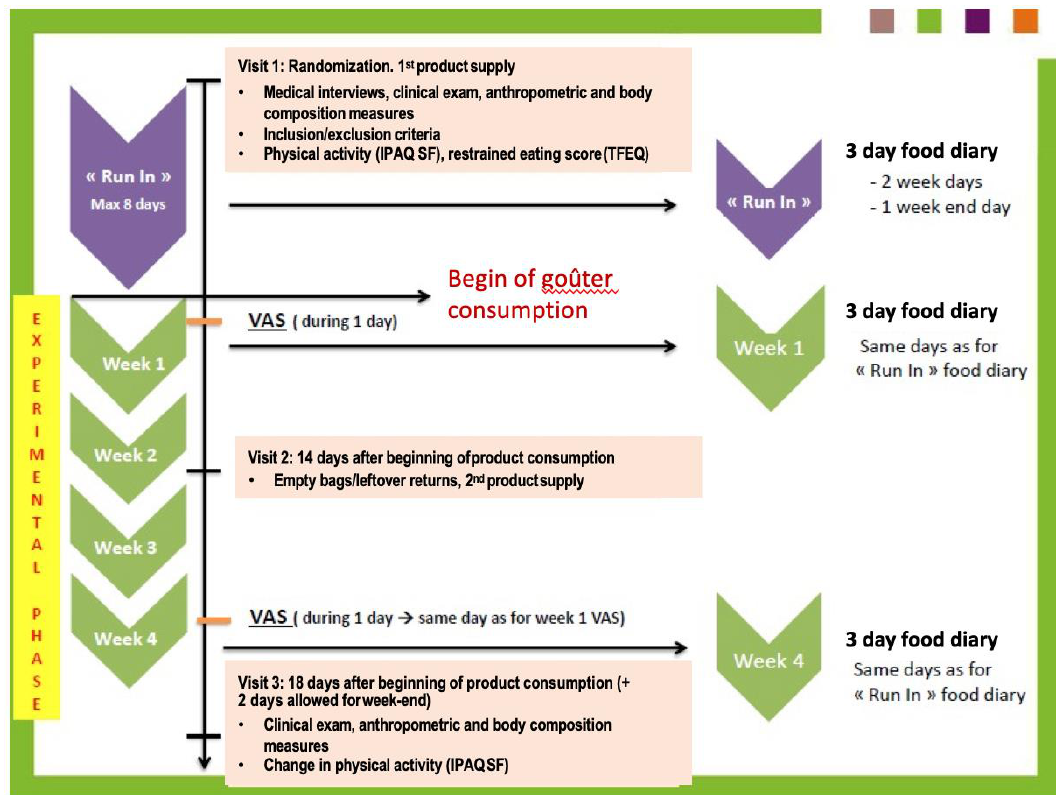
Figure 1. Experimental design .